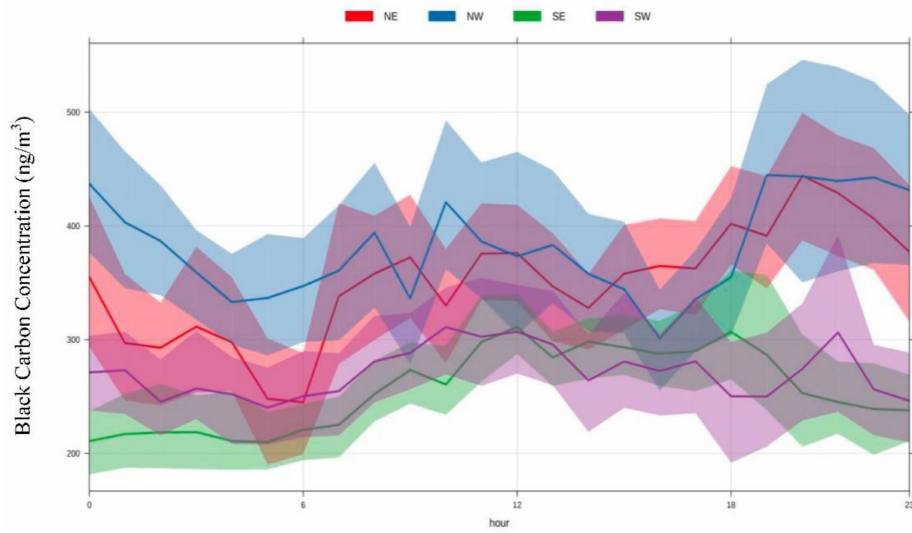
Figure 6. Average black carbon concentration relationship with four main wind